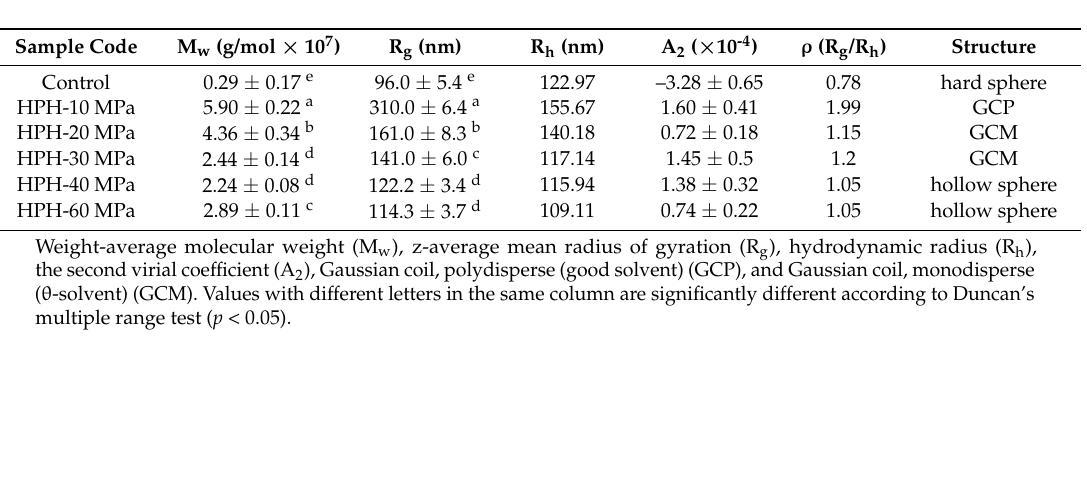
Table 1. Summaries of the dynamic and static light scattering data on the soluble aggregates in the SPI aqueous solutions with HPH treatment.